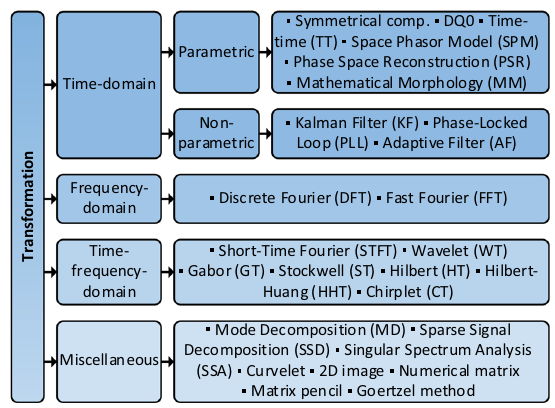
Mode Decomposition (MD) Sparse Signal Decomposition (SSD) Singular Spectrum Analysis (SSA) Curvelet 2D image Numerical matrix Matrix pencil Goertzel